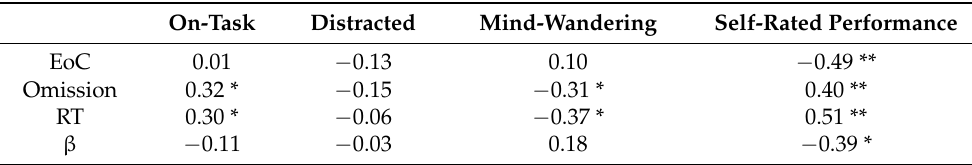
Table 4. Bivariate correlation between SART performances and subjective ratings of attentiveness.